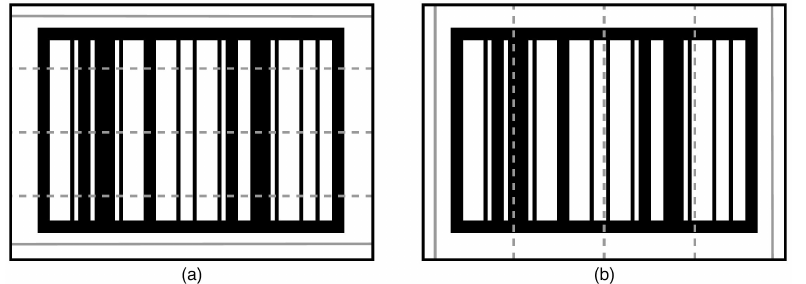
Figure 5. Diagram showing the sample lines that are extracted from images potentially containing barcodes. ( a ) five horizontal sample lines, ( b ) five vertical sample